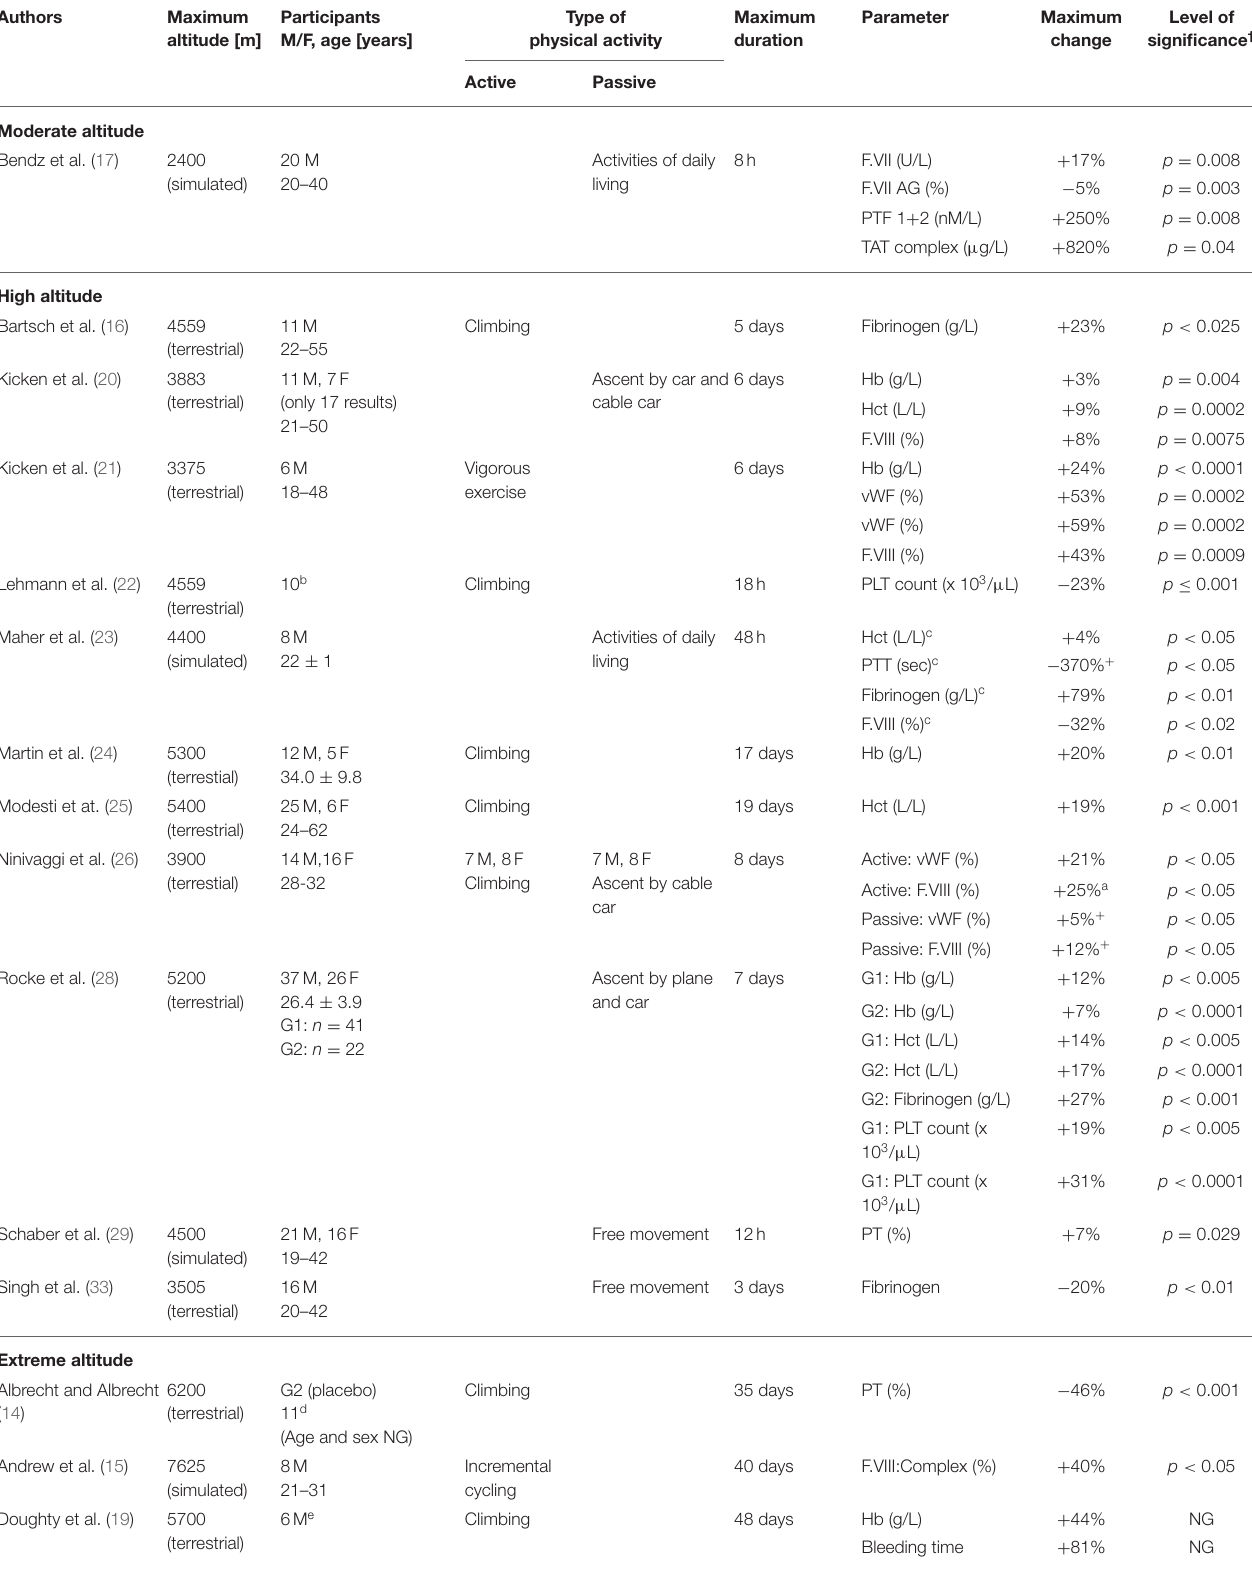
TABLE 2 | Changes of standard coagulation parameters, coagulation factors, red blood cells and platelet count during exposure to moderate, high and extreme altitudes (16 studies, n =